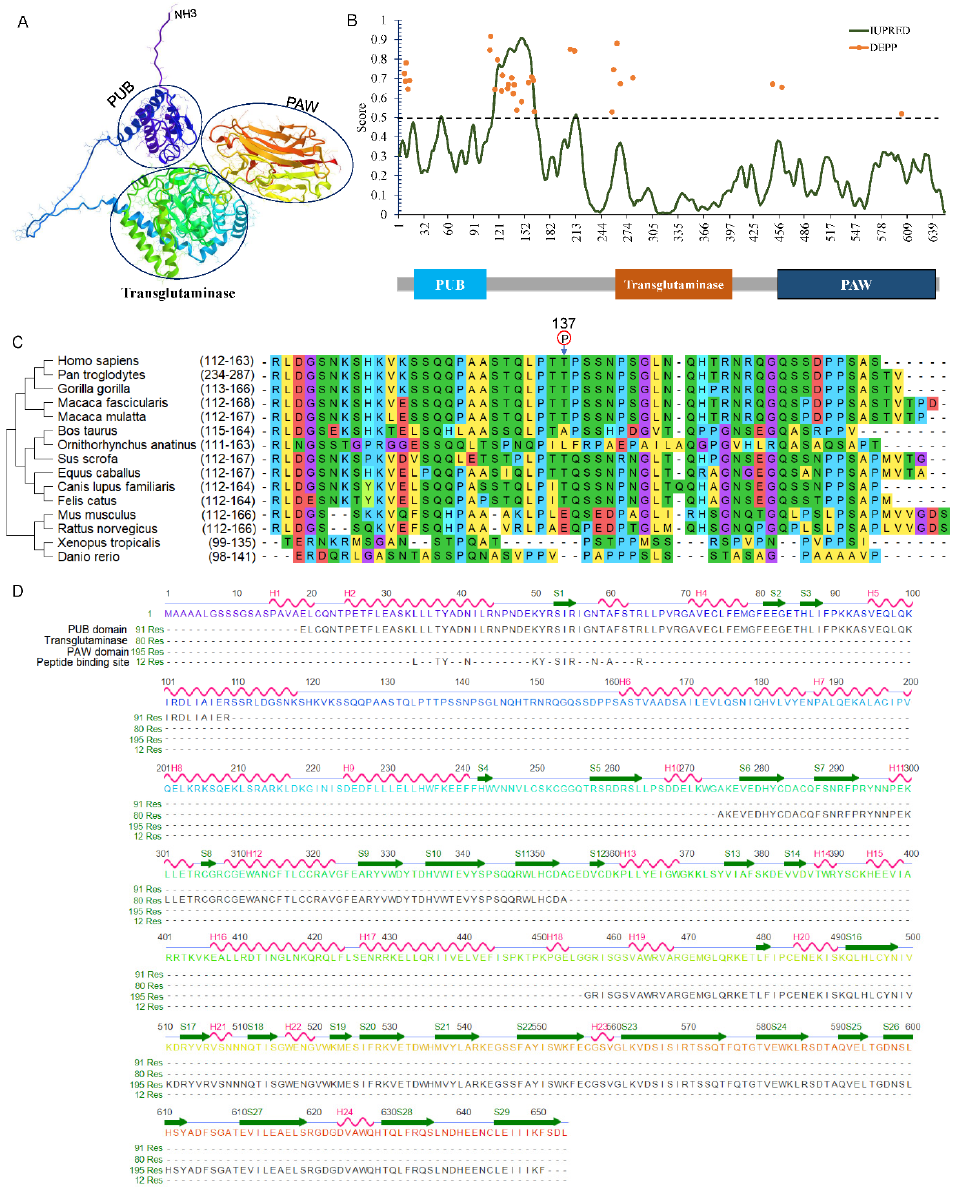
Figure 3. Structural analysis of human NGLY1. ( A ) Three-dimensional structure predicted by Al- phaFold; ( B ) Intrinsically-disordered region of NGLY1; ( C ) Alignment of the intrinsically-disordered region; ( D ) Secondary structure of NGLY1.